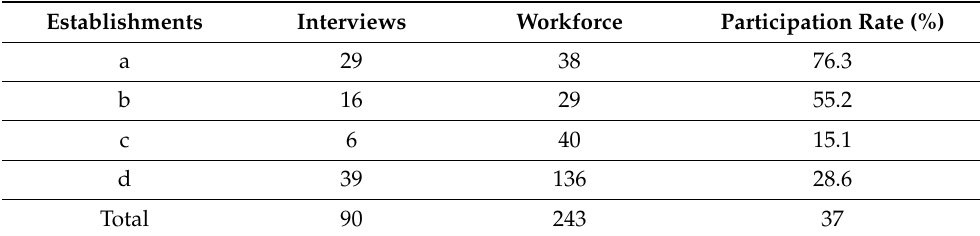
Table 3. Inclusions of interviews by the establishment.